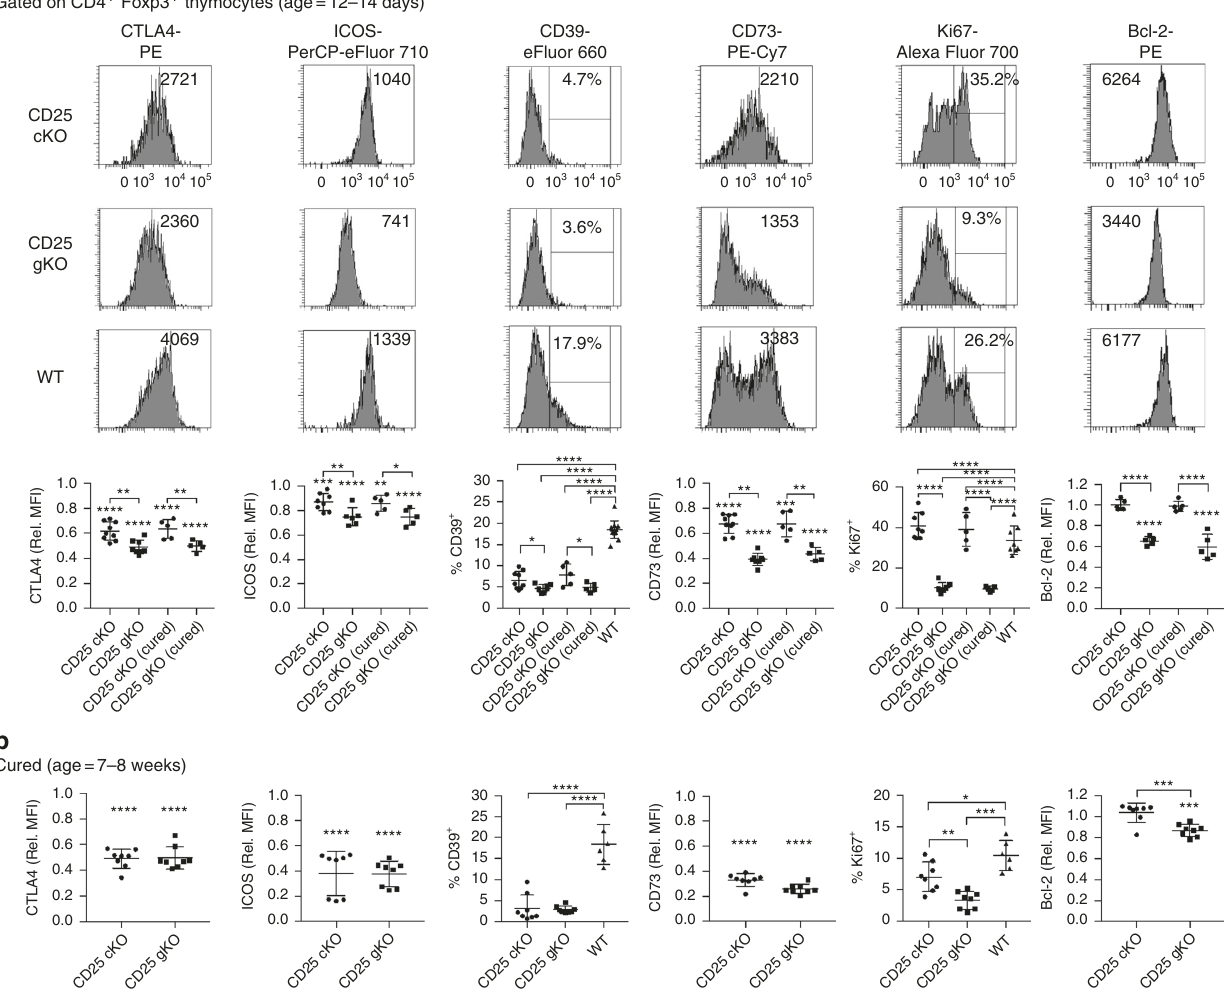
Fig. 3 Abnormal programming of thymic Treg precursors in CD25 cKO and CD25 gKO mice. a Representative histograms (upper panels) and scatter plots (lower panels) showing expression of indicated markers, gated on CD4 + Foxp3 + thymocytes from CD25 fl ox/Foxp3-YFP/Cre (CD25 cKO ) and CD25 gKO mice (age = 12 – 14 days; n = 5 – 13 mice per group). b The indicated markers in ( a ) were evaluated in host-derived CD4 + Foxp3 + thymocytes from “ cured ” adult CD25 cKO and CD25 gKO mice (age = 7 – 8 weeks; n = 6 – 8 mice per group). Rel. MFI = relative MFI normalized to CD25 WT controls. Each symbol represents an individual mouse ( a , b ; mean ± SD). * p < 0.05, ** p < 0.01, *** p < 0.001, **** p < 0.0001. Symbols located directly above a single group of dots represent the comparison of that group against normalized WT control values (one sample t test); symbols located above brackets connecting two groups of dots represent inter-group comparisons (two-tailed Student ’ s t test). Data are representative of ( a ) or pooled from ( a , b ) four independent